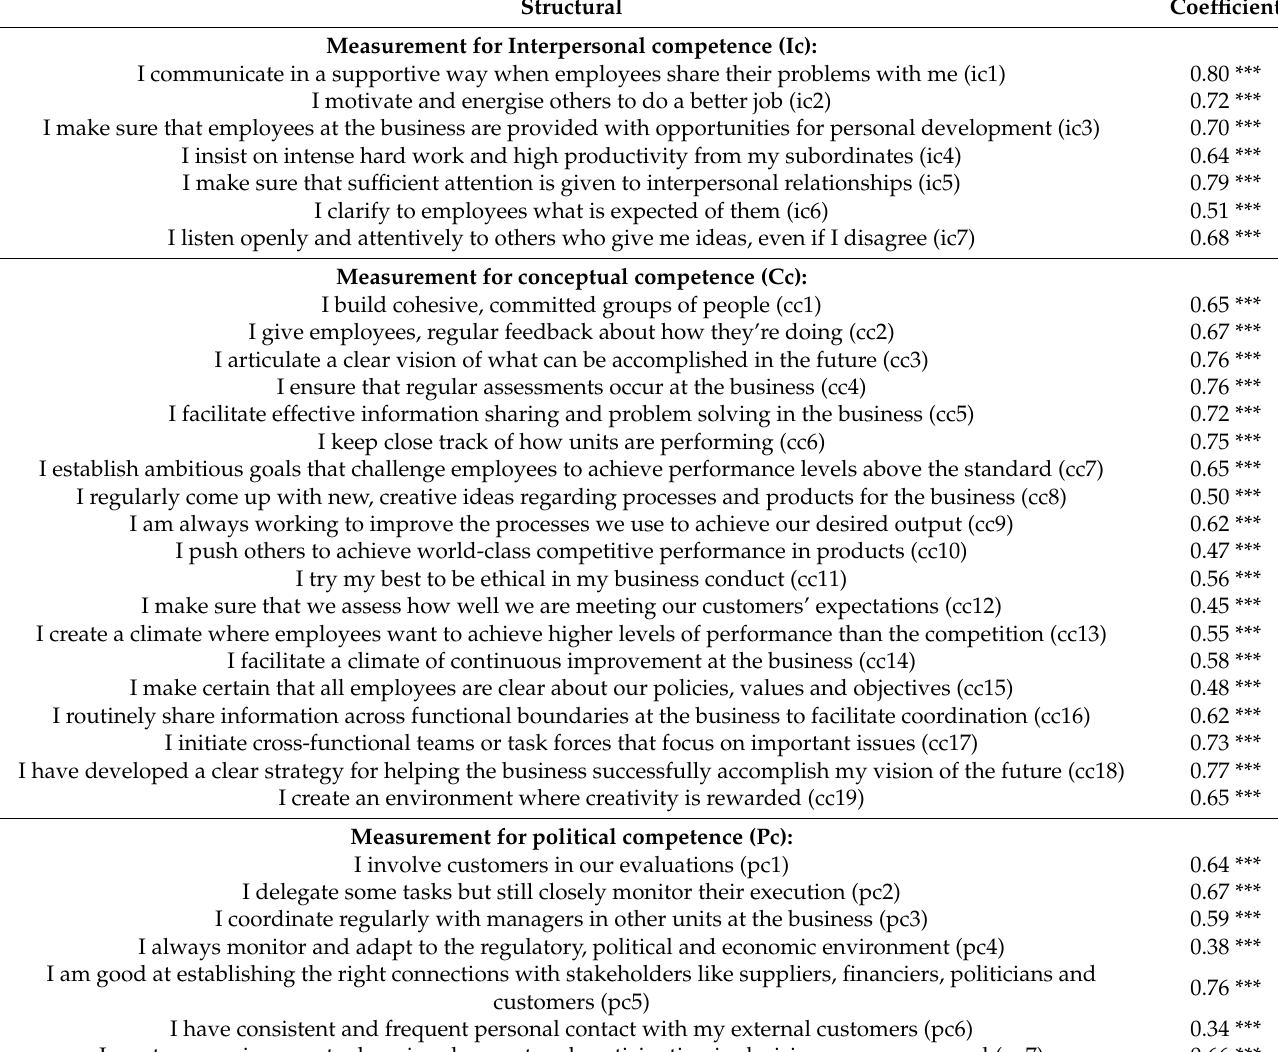
Table 4. Cont. Structural